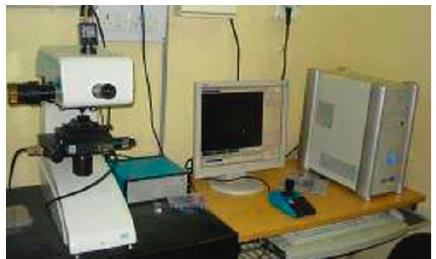
Figure 5: Microhardness tester (UHL VMHT